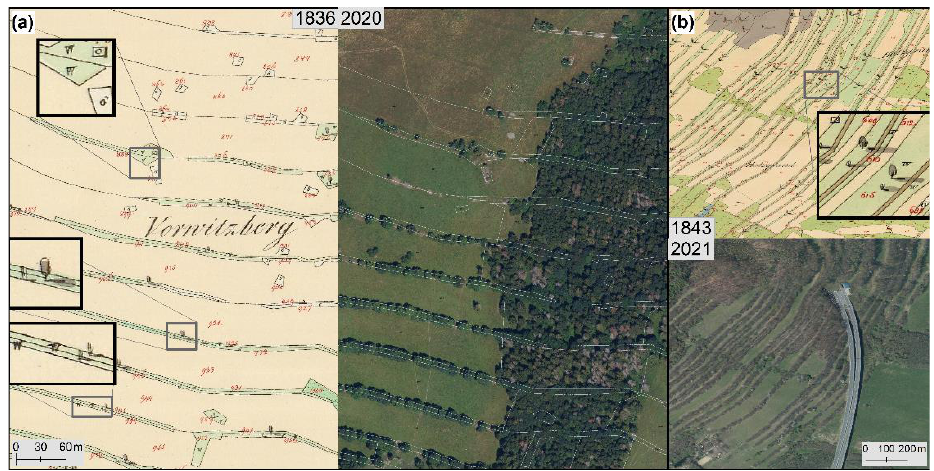
Figure 4. Different land-use of HALs: ( a ) Heřmanovice in the Jeseníky Mts, ( b ) Knínice in the Krušné Hory Mts in the Franciscan Cadastre (1842) and a recent orthophotograph map (2020) showing the former and present state with cadastre parcel boundaries in white [data sources: Imperial Imprints of the Stable Cadastre Bohemia (Franciscan Cadastre) provided by the ˇC Ú ZK, Praha, Czech Republic— map lists 0702-1 (Silesia), 3211-1 (Bohemia); archive map legend: fields—beige; barren land, infertile soil, rock, fallow land—white with ö, meadow—light green; pasture—light green with W; agroforestry land use categories: meadow/pasture with signs of shrub and/or broadleaved trees; wet meadow— hatched light green; forest—grey; Orthophoto of the CR, ˇC Ú ZK, Praha, Czech Republic; processed in ArcGIS, ESRI, Redlands, CA,